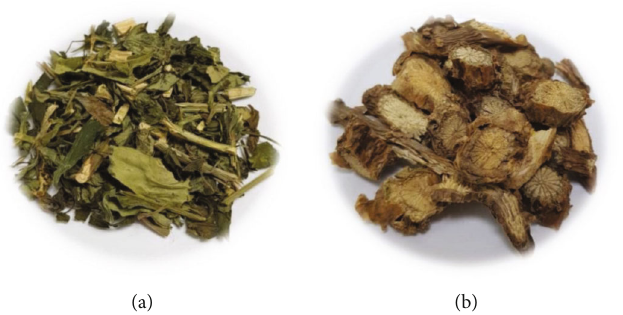
Figure 1: Dried aerial parts of A. paniculata (a) and stems of T. crispa